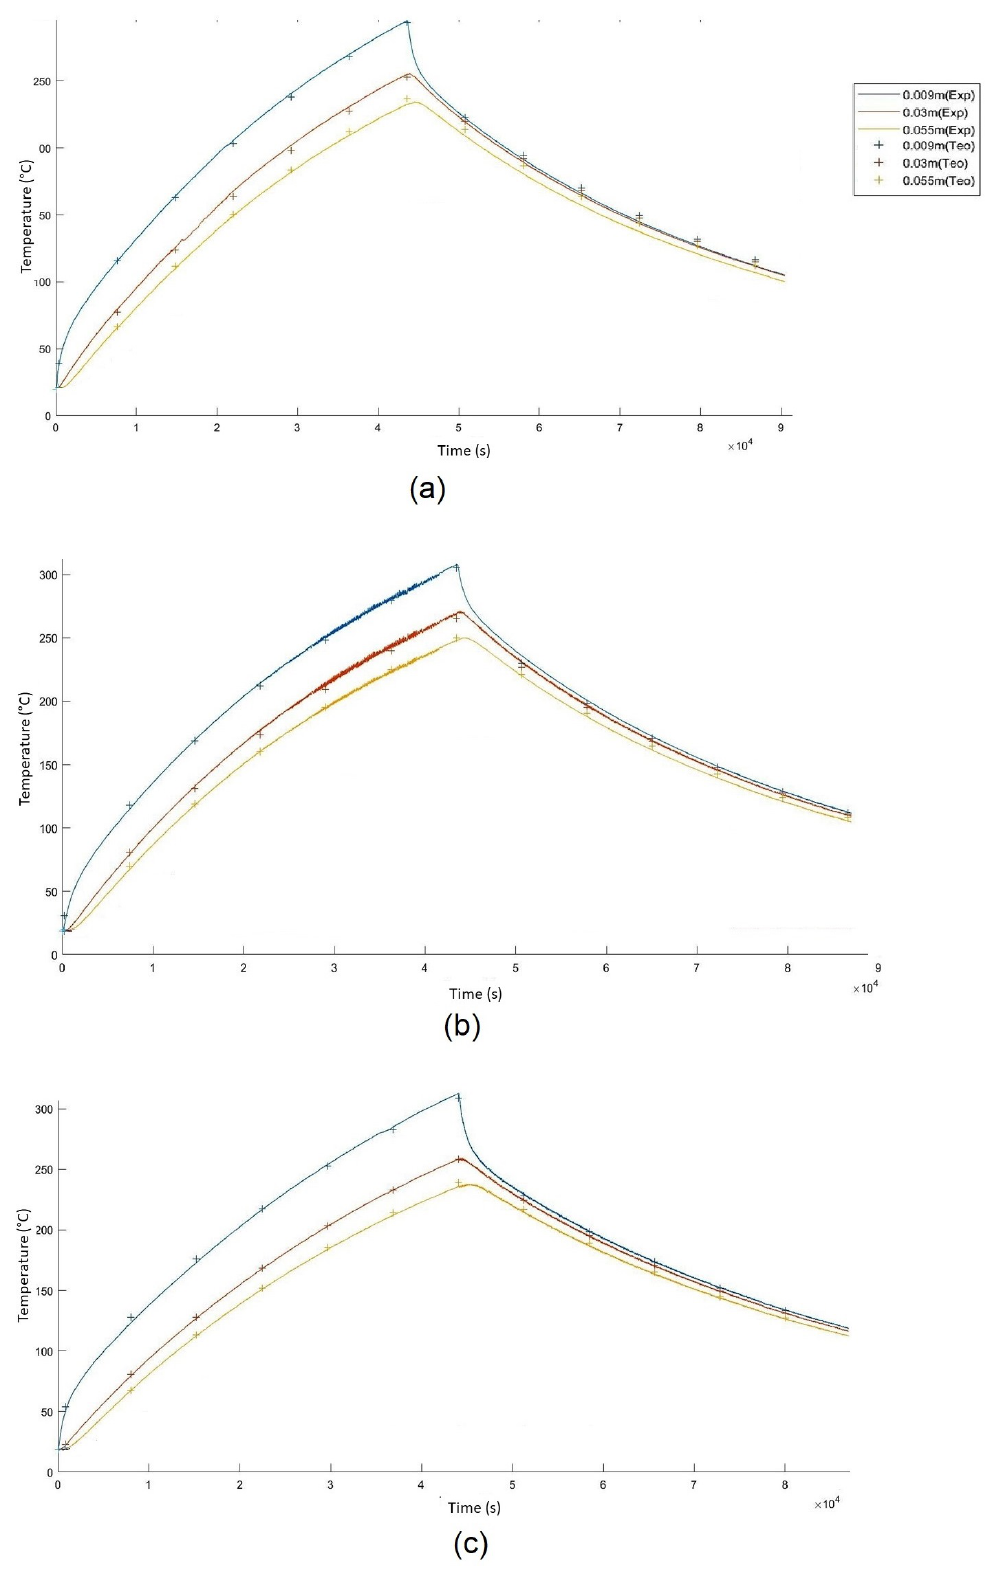
Figure 9. Theoretical and experimental curves for a heating and cooling cycle. The crosses represent the temperatures returned by the software and the line the actual temperatures: ( a ) temperature graph for lot TQ; ( b ) temperature graph for lot OS; ( c ) temperature graph for lot